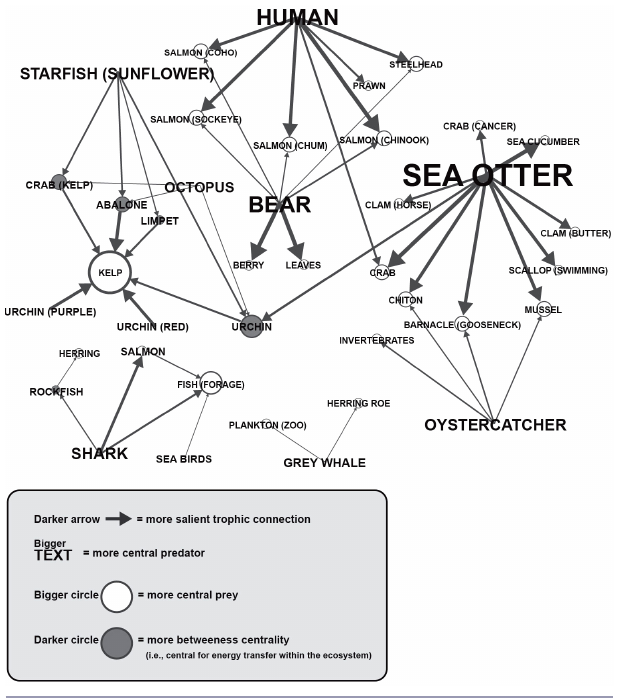
Fig. 2 . Aggregate mental model of the regional food web: government managers. The feeding habits of sea otters, humans, and bears appear especially salient for government managers. Managers also appear to think of fish species and those species’ respective trophic relationships at a much higher phylogenetic resolution than do civilians. Furthermore, unlike local civilians, managers appear particularly cognizant of the trophic relationships that constitute the kelp-and-urchin centered subsystem that is directly impacted by the trophic cascade of sea otter predation. Finally, the charismatic killer whale appears conspicuously absent from managers’ cognitive representations of the marine ecosystem, while two other, less iconic predators, sharks and sunflower starfish, both serve important structural roles in managers’ aggregate model. (Note that this visualization is demonstrative of the method’s potential uses, not necessarily representative of a demographic with statistically distinct